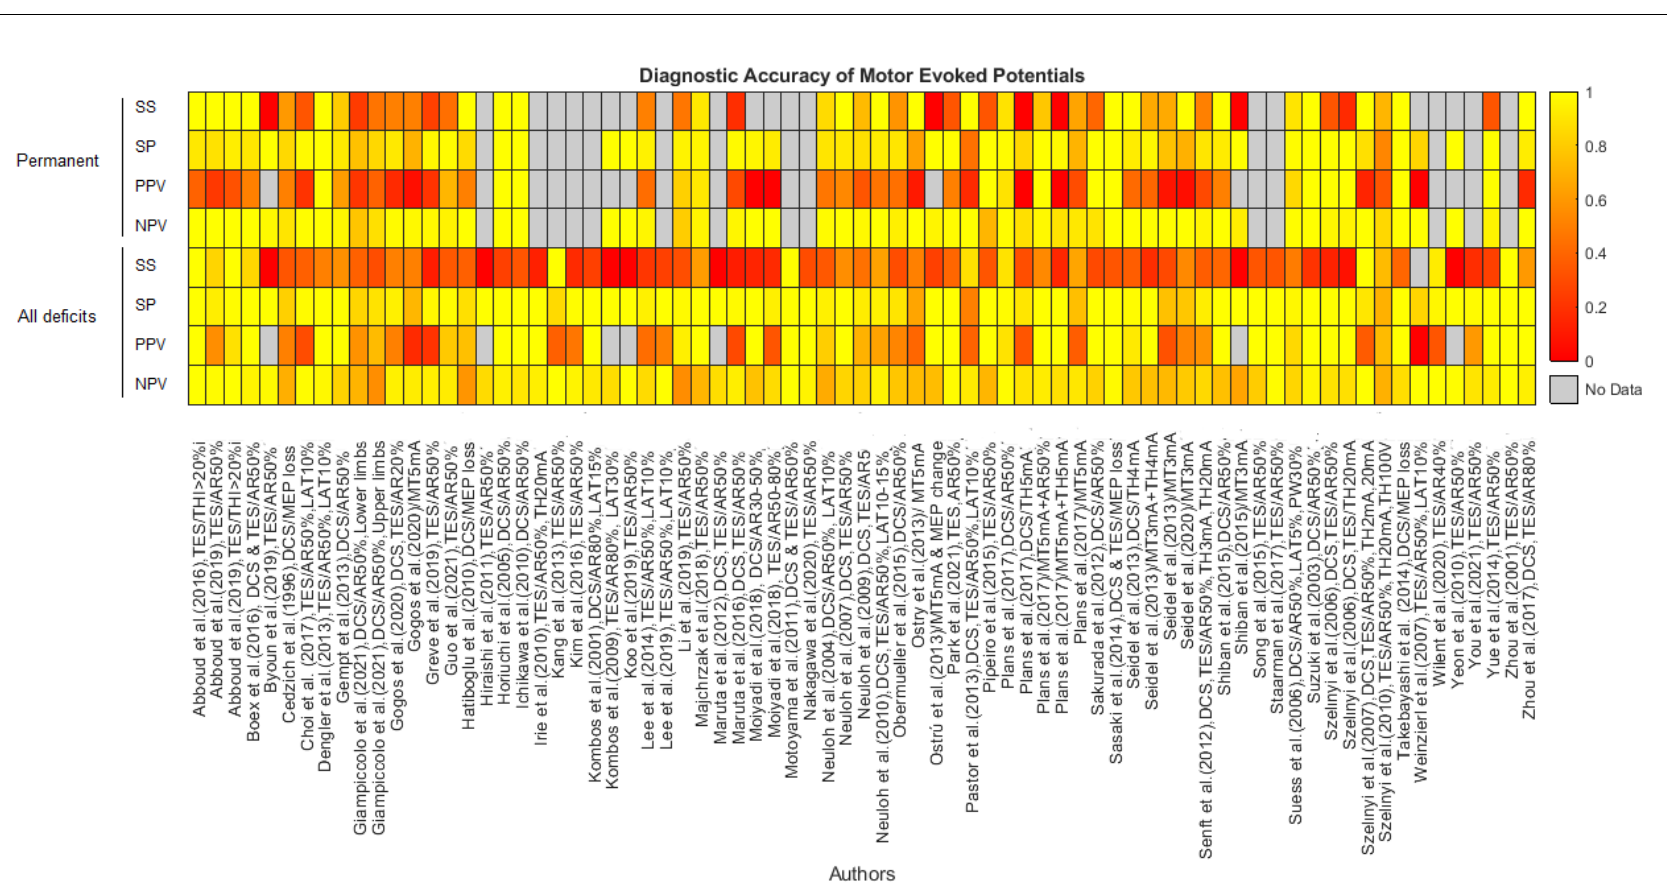
Figure 2. Heatmap depicting sensitivity (SS), specificity (SP), Positive Predictive Value (PPV), and Negative Predictive Value (NPV) estimates for permanent and all motor deficits (regardless of the time) across different studies. The scale ranges from 0 (red) to 1 (yellow). If the study did not provide sufficient data for the calculation of an estimate, the corresponding area is colored grey. Irreversible MEP changes were considered as positive results, whereas reversible MEP changes and the absence of MEP changes were considered as negative results.